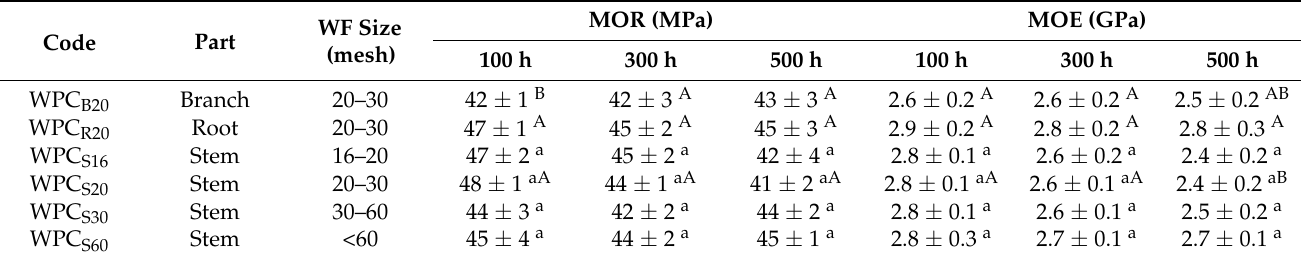
Table 2. The flexural properties of various WPCs after xenon arc accelerated weathering for 100, 300, and 500 h.